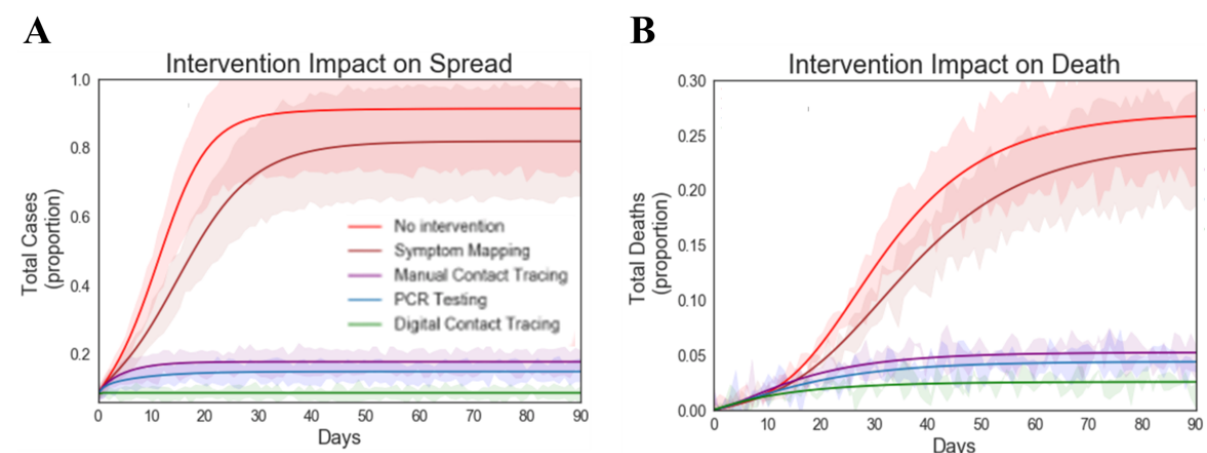
Figure 5. Quantifying control success for each intervention group. A: total cases (proportion) over time. B: total deaths (proportion) over time. Simulations were performed for all intervention groups using initial seeding conditions: 10 cases (40% presymptomatic and 60% symptomatic cases). Time delay to trace for digital contact tracing (0.1 days), symptom-based mapping (1 day), manual contact tracing (2 days), and PCR testing (1 day). Simulations were performed to measure the total cases and deaths as a function of time for each intervention group: digital contact tracing, PCR testing, manual contact tracing, symptom-based monitoring, and no intervention. PCR: polymerase chain